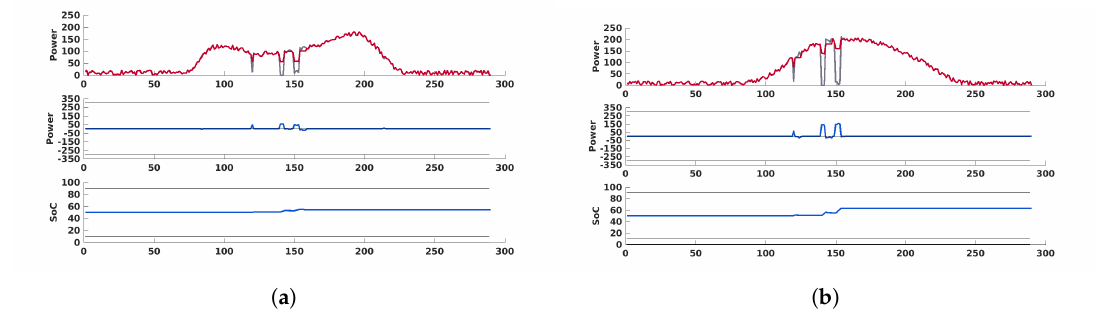
Figure 12. Top: Grid power flow with SR ( P g , red) and without SR ( P hcpv , grey). Middle: Battery power evolution ( P ess , blue) and constraints (grey). Bottom: Battery SoC evolution (blue) and constraints (grey). On a cloudy day case ( a ), on a sunny day ( b